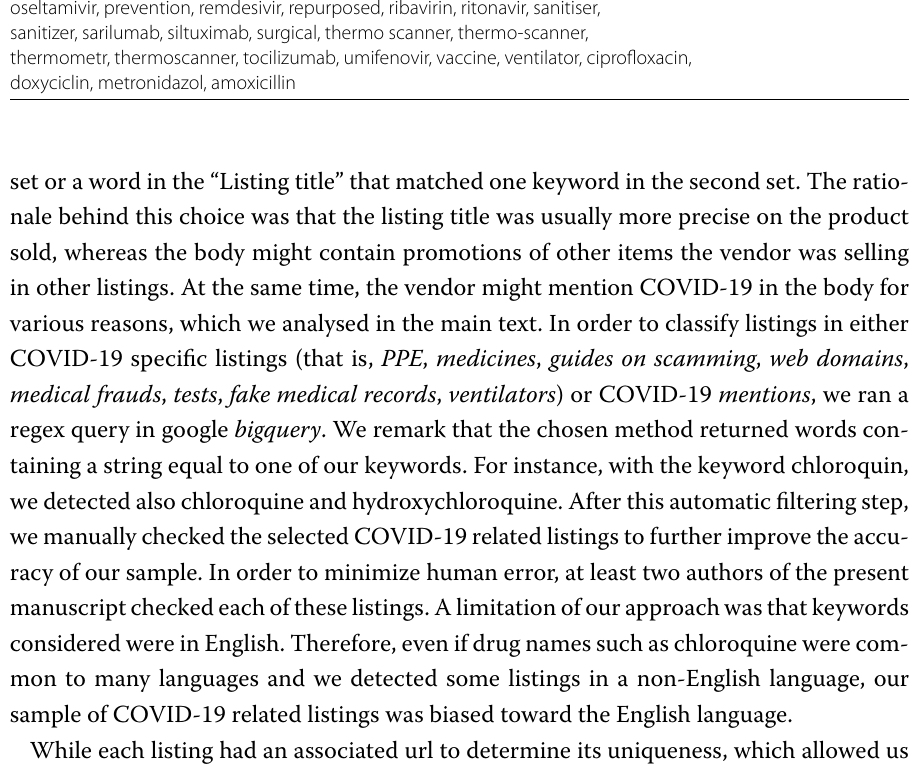
Table 5 Keywords used to sample COVID-19 specific listings from the DWMs in Table 2 Firstsetofkeywordscheckedagainstthewordsincludedintheattribute“Listingbody”inTable 4 corona virus, coronavirus, covid, covid-19, covid19 Secondsetofkeywordscheckedagainstthewordsincludedintheattribute“Listingtitle”inTable 4 anakinra, antidote, antiviral, azithromycin, baloxavir, baricitinib, bemcentinib, chloroquin, corona virus, coronavirus, covid, covid-19, covid19, darunavir, dexamethason,